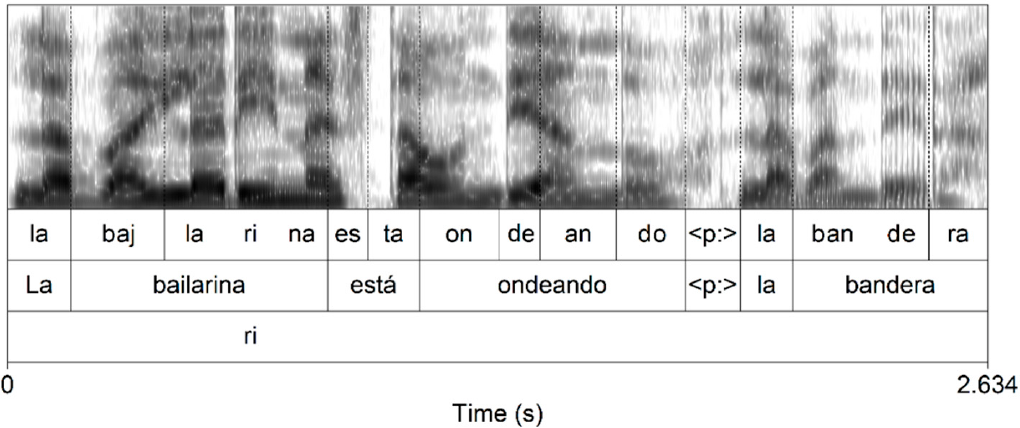
Figure 3. Example of labeling of the target syllable ( ri ) in the broad focus utterance La bailarina est á ondeando la bandera ‘The dancer is waiving the flag’, uttered by a female